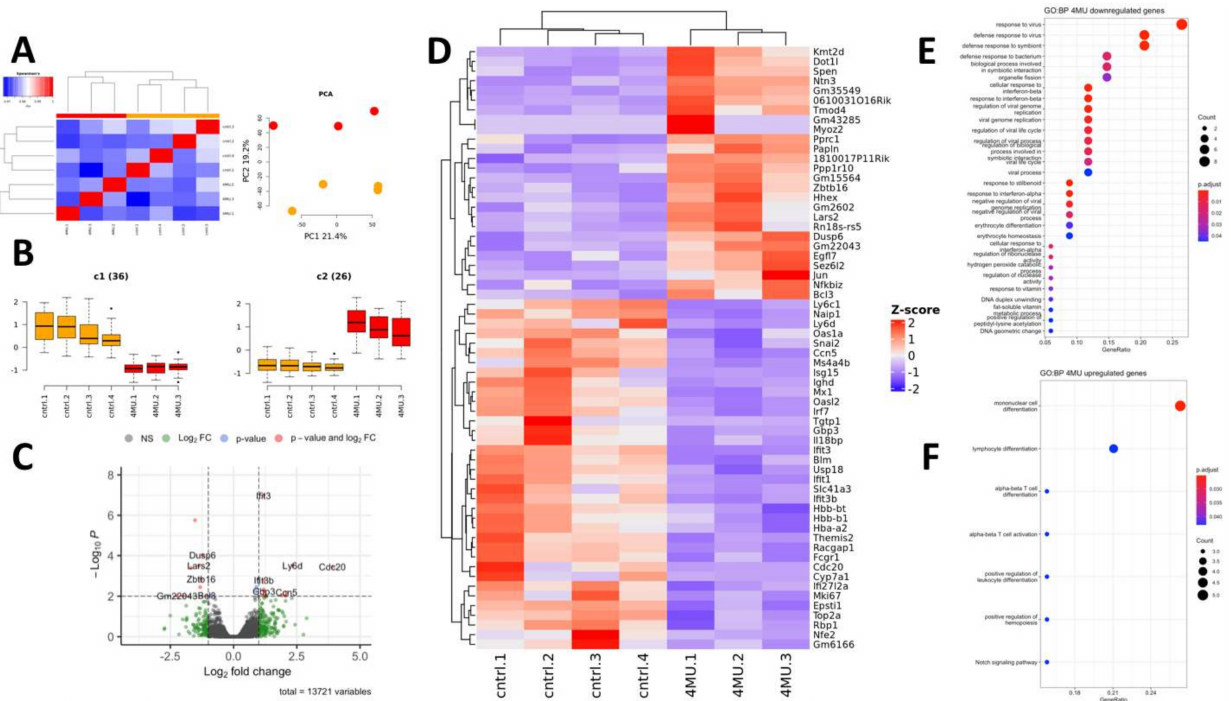
Figure 5. Characterisation of 4MU differentially expressed genes. ( A )—Correlation between con- trol and 4MU-treated samples. ( B )—Mean expression of down- and upregulated genes across the samples; ( C )—Volcano plot of differentially expressed genes; ( D )—Heatmap of DEGs. ( E )—Pathway enrichment analysis of down-regulated genes; ( F )—Pathway enrichment analysis of upregulated genes; Gene ratio—the number of DEG which falls into the specific pathway to the total number of genes in this pathway. Symbol meaning 6B: c1(36) the number of down regulated genes ( n = 36) in 4MU group (4MU.1, 4MU.2, 4MU.3) in comparison with control group (cntrl.1, cntrl.2, cntrl.3, cntrl.4 (cid:48) ); c2(26) the number of up regulated genes ( n = 26) in 4MU treated